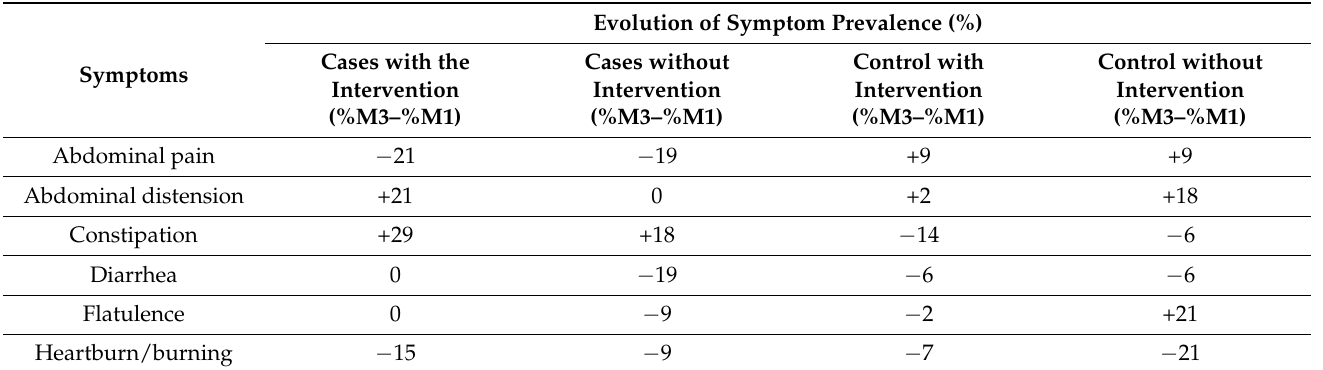
Table 6. Gastrointestinal symptomatology changes between M1 and M3 of different